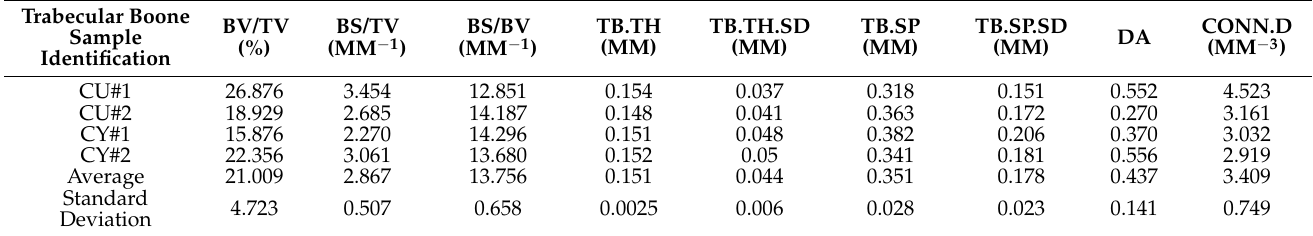
Table 4. Trabecular bone analysis in ImageJ BoneJ.